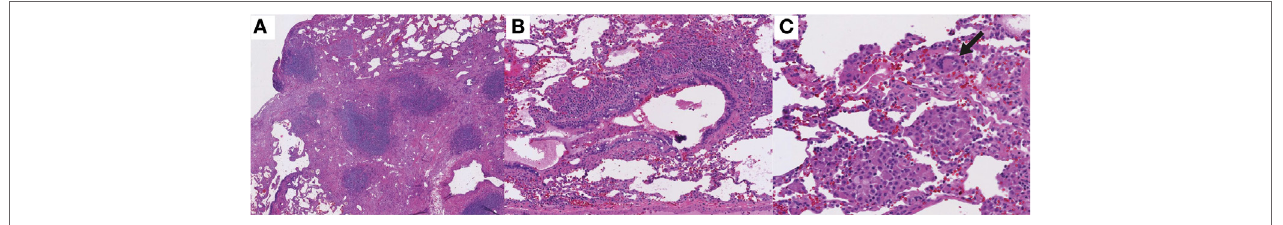
FigURe 5 | Histologic features of granulomatous-lymphocytic interstitial lung disease. (A) Lymphocytic interstitial pneumonitis. Diffuse, lymphocytic interstitial infiltrates obliterating the alveolar spaces in some areas (100 × ). (B) Follicular bronchiolitis. Nodular, lymphoid peribronchiolar aggregates (100 × ). (C) Non-necrotizing granuloma with multinucleated giant cells (arrow; 200 × ). Hematoxylin and eosin staining.